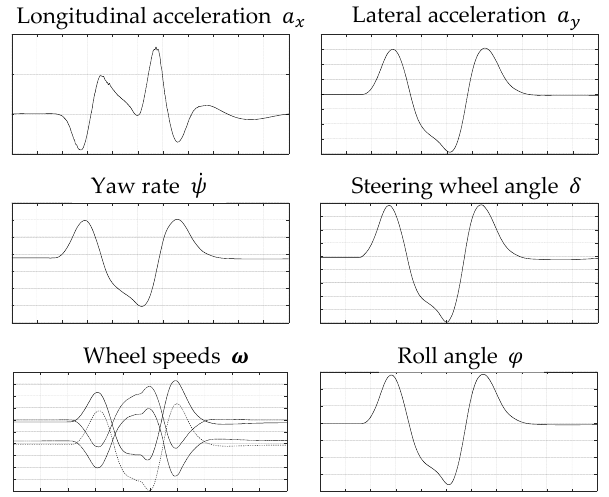
Figure 4. Driving data for the double lane change maneuver.